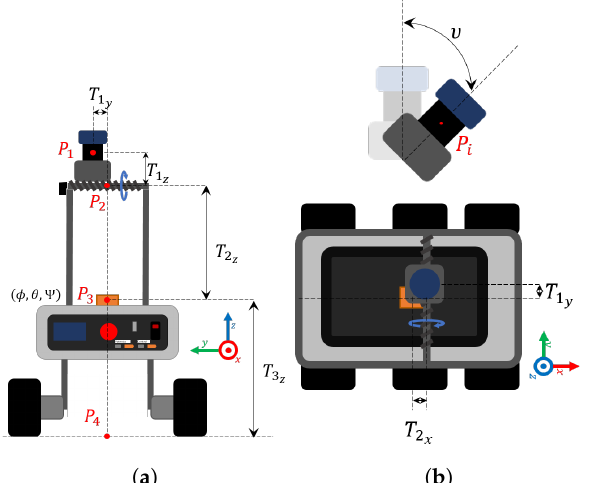
Figure 7. Schematic diagram of the mapping system and notations for different coordinated frame points to transform initial points from LiDAR to the reference frame P o : ( a ) rear view of vehicle, ( b ) top view of the